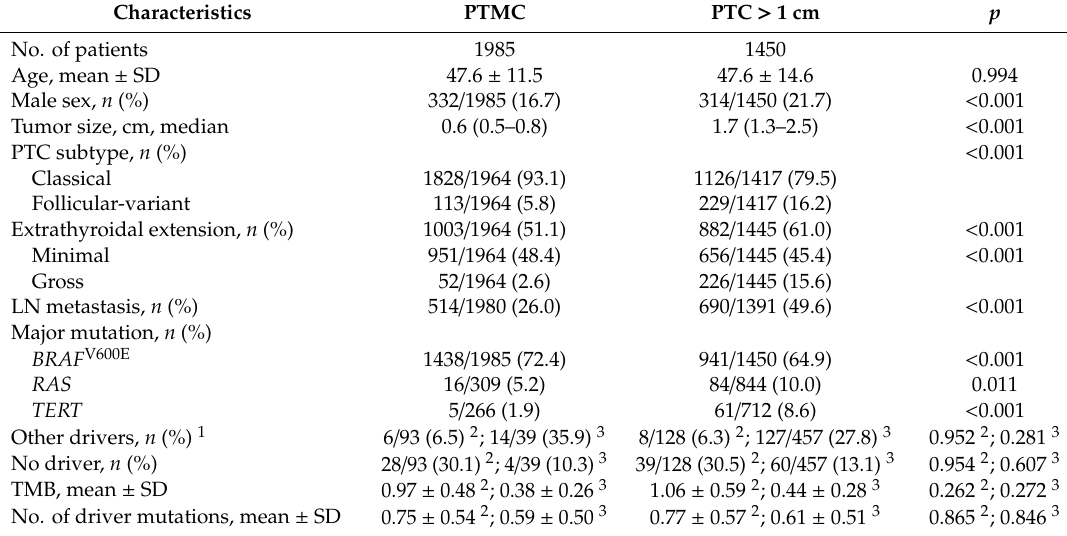
Table 1. Clinicopathological and genomic characteristics of papillary thyroid microcarcinoma (PTMC) and papillary thyroid carcinoma (PTC) > 1